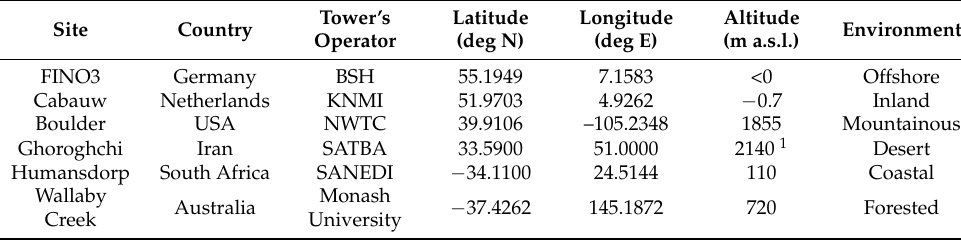
Table 1. Characteristics of the study sites where tall towers are